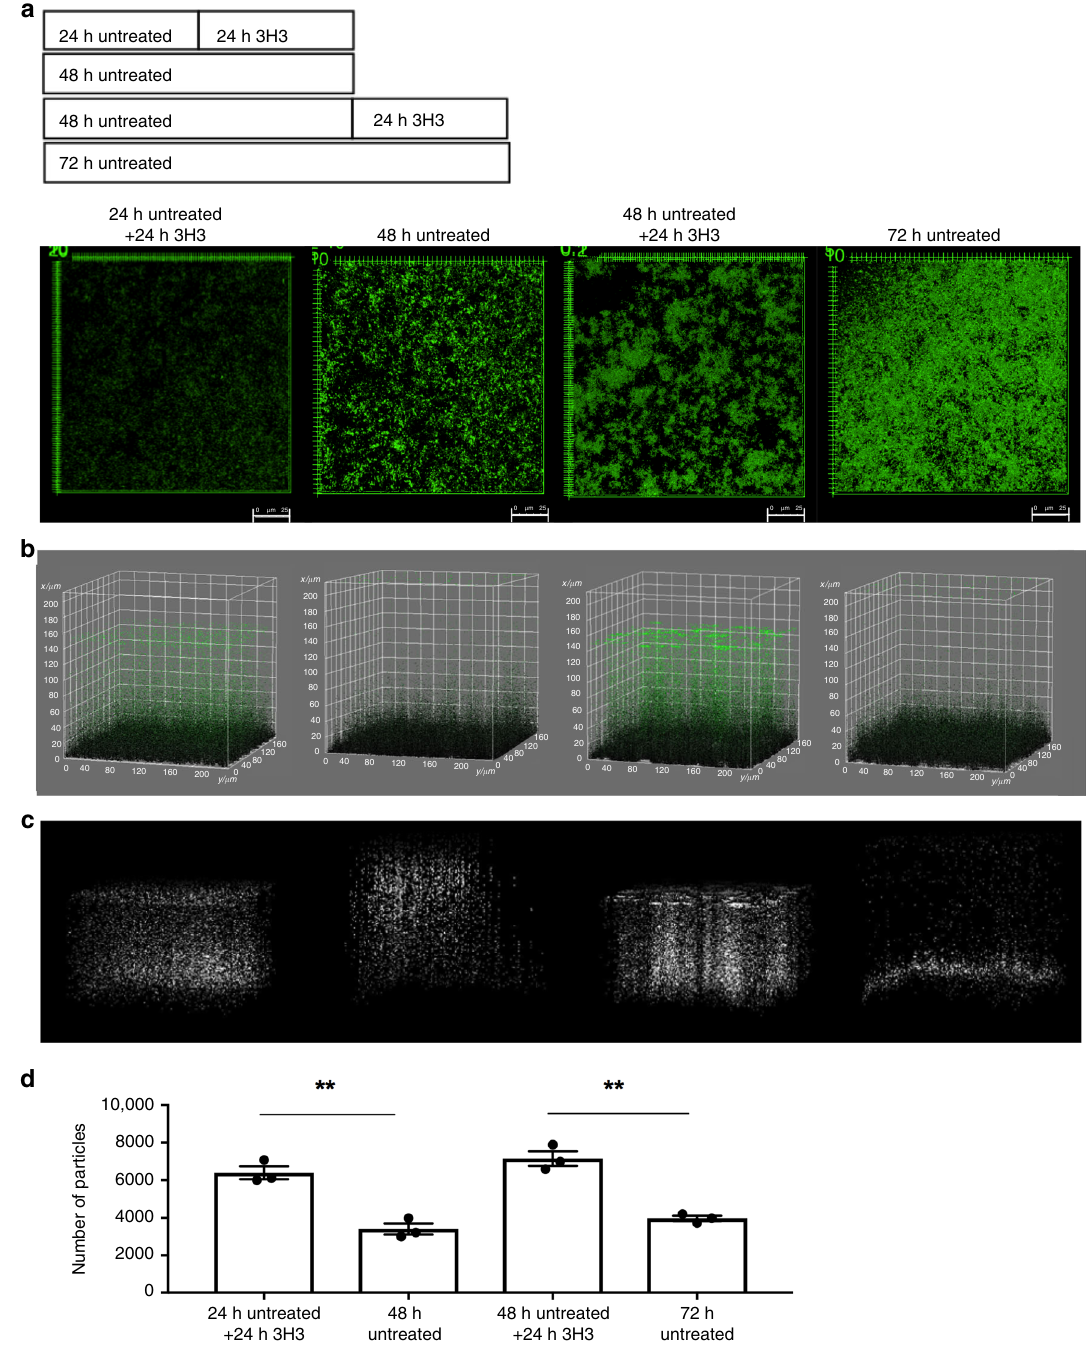
Fig. 3 3H3 alters the architecture of pre-established S . Typhimurium bio fi lms. a Experimental schematic and representative images of bio fi lms established for 24 and 48 h and then incubated for an additional 24 h without or with 0.5 mg/ml 3H3. Bio fi lms were stained with Syto9 (green) and visualized using Leica TCS confocal microscopy at ×63. Scale bars represent 25 μ m. b 3D surface plots of bio fi lms depicted in a created in ImageJ. All bio fi lm particles are colored green. c 3D surface plots in which particles above the mean bio fi lm mass appear in white as determined by the 3D surface plot application in ImageJ. d Number of particles above the mean bio fi lm mass enumerated using ImageJ. Mean and SE were calculated from results from at least three independent experiments. * p < 0.05, ** p < 0.01 as determined by Student ’ s t treatment of catheters pre-colonized with S . Typhimurium would after catheter insertion, mice were euthanized and the catheters enhance bio fi lm clearance in vivo. We pre-colonized intravascular were removed. Excised catheters were stained with Syto9 and catheters for 24 h with S . Typhimurium and then implanted the Congo Red and visualized using confocal microscopy. On catheters subcutaneously into the back fl anks of BALB/c mice. At catheters from cohorts of mice not treated with mAb, bio fi lms 24 and 48 h after catheter insertion, 100 μ g 3H3 or buffer solution formed a dense matrix with bacteria encapsulated within curli was percutaneously injected into the catheter lumens. At 72 h (Fig. 5b, upper left). In contrast, catheters from cohorts that